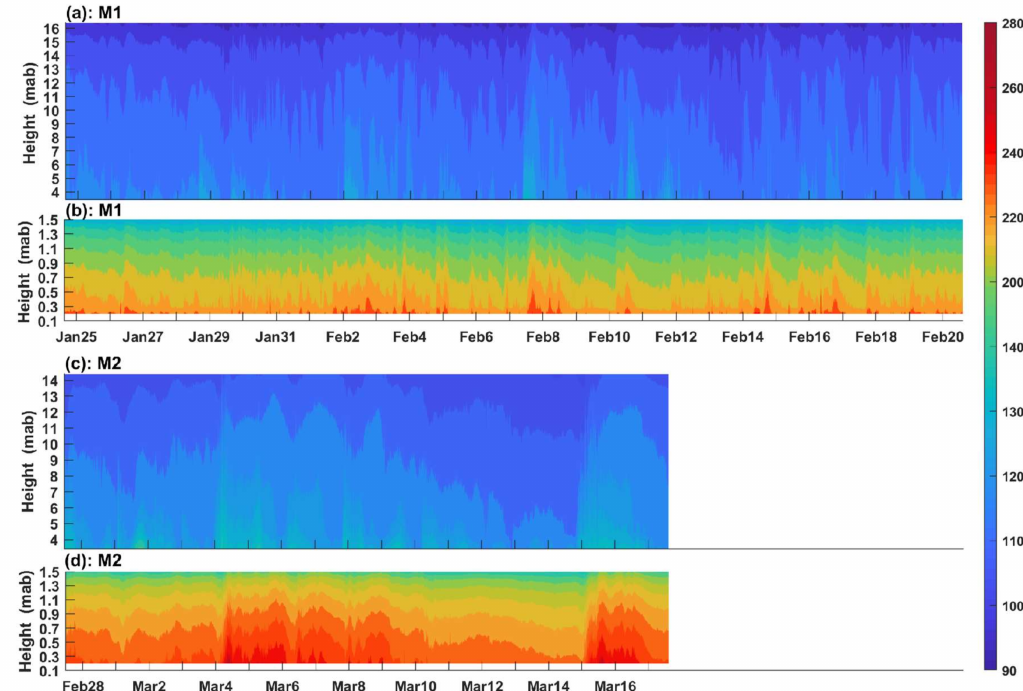
Figure 7. Vertical profile of backscatter intensity at full water depth, estimated by the echo intensity measured by the upward-looking ADCP ( a , c ) and downward-looking PCADP ( b , d ). 3.3.2. Volume Concentration, Particle Size Distribution, and Turbidity of Suspended Sediment at the Bottom